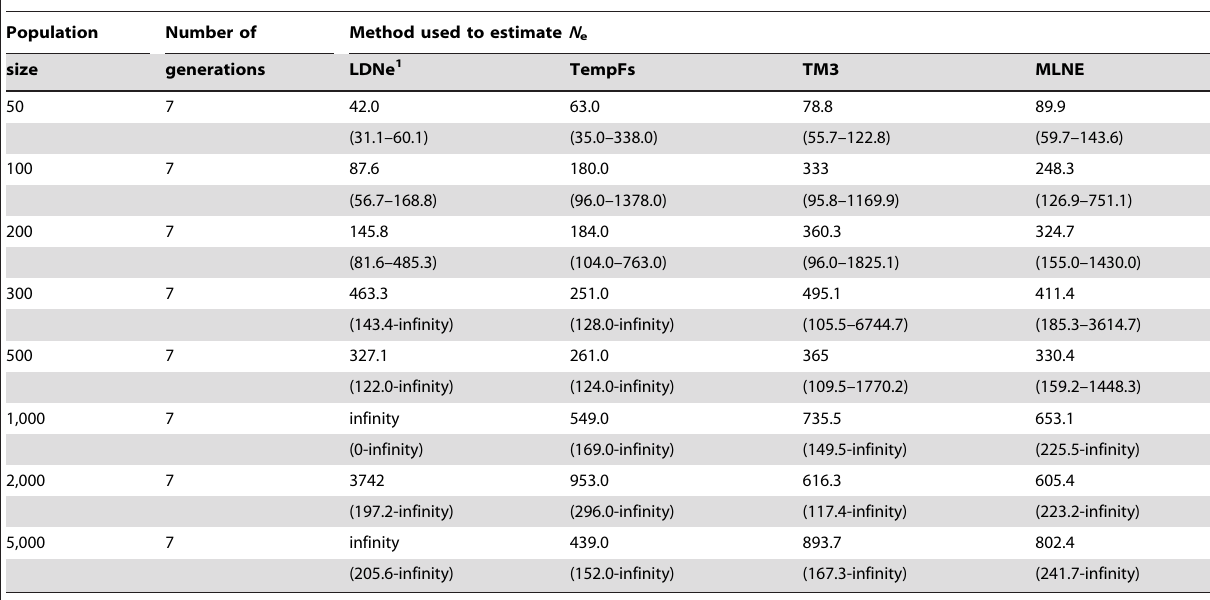
Table 3. Estimates of N e from simulated populations of known